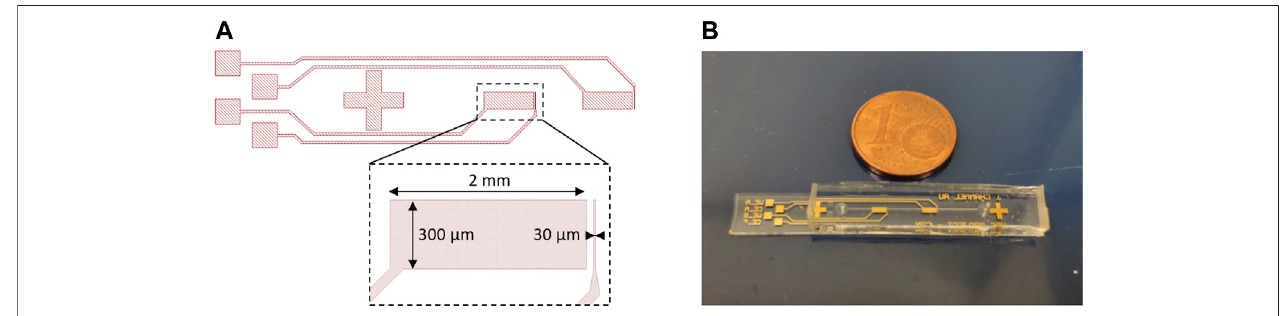
FIGURE 1 | (A) Biosensor geometry, designed using KLayout software, with the detection area dimensions — working electrode (WE) (width 300 μ m, length 30 µm), counter electrode (CE) (width 300 μ m, length 2 mm). (B) Photography of the fi nal micro fl uidic device composed of two pairs of gold electrodes (WE, CE) for repeatability of